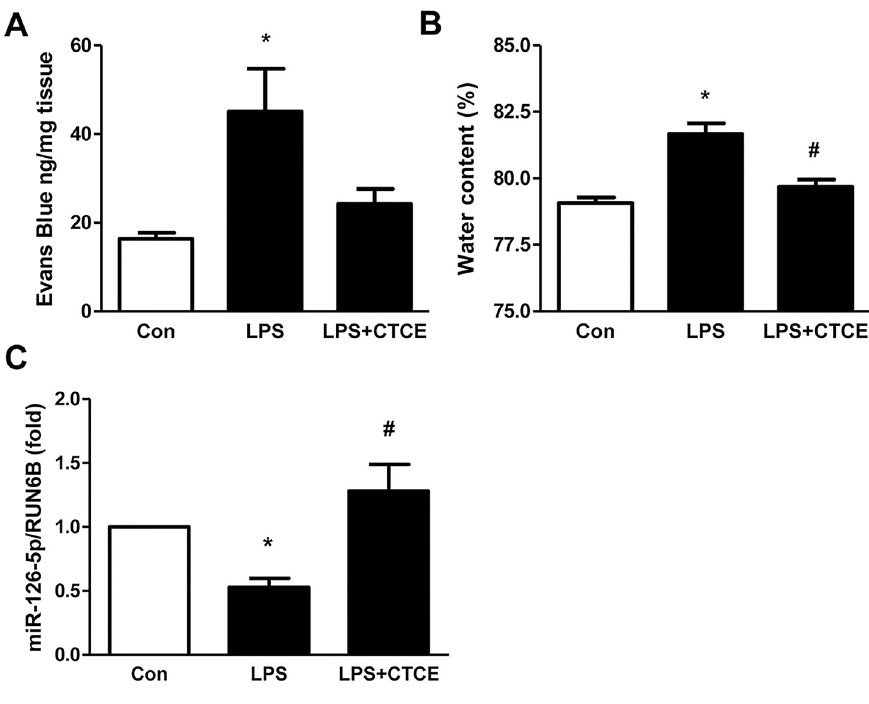
Figure 8. CTCE decreased lung vascular leak and water content and increased miR-126 levels in LPS-induced ARDS. ARDS was induced by intratracheal instillation of LPS. Evans blue dye was injected to determine lung vascular leak (A). Lung tissue wet/dry ratio was determined as an index of lung water content (B). MicroRNA-126 expression was determined by real-time PCR of whole lung homogenate (C). * p < 0.05 compared with control group, # p < 0.05 compared with LPS groups. N = 5–6